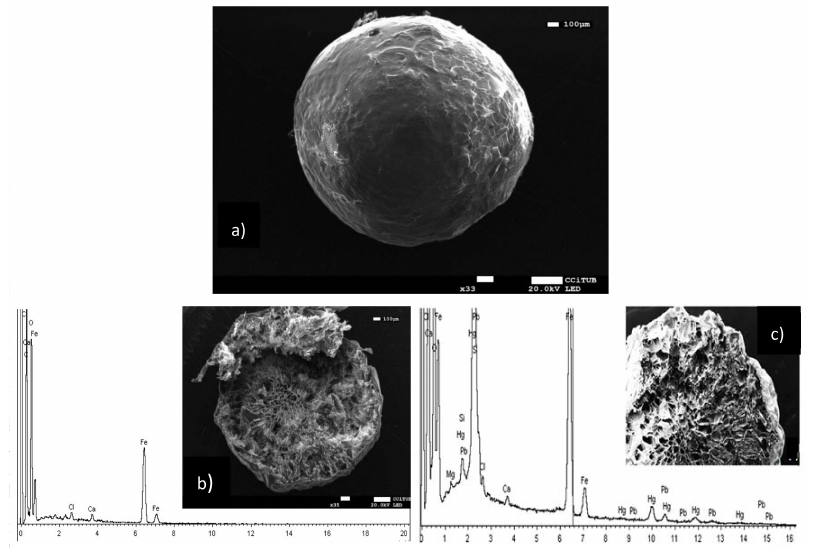
Figure 1. SEM-EDX images. ( a ) ChiFer(III) bead, ( b ) segmented/cross sectional view and EDX of ChiFer(III) bead, ( c ) segmented view and EDX of ChiFer(III) bead after sorption of Hg(II) and